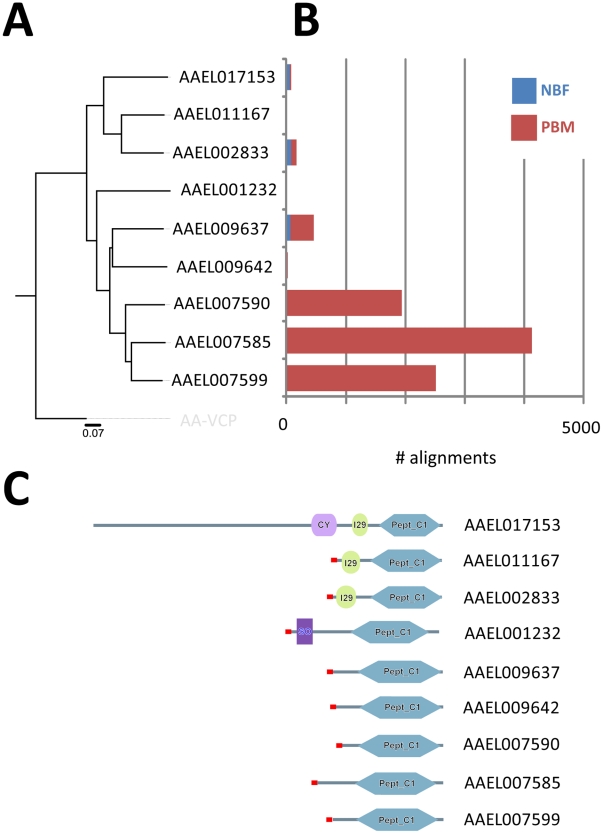
The VCB family of Aedes aegypti.
A. Neighbor joining tree showing evolutionary relationships of Ae. aegypti VCBs. B. Number of VCB reads identified in the NBF and PBM libraries. All cathepsins identified in Ae. aegypti which had reads align using the methods used for sequence alignment and data analysis, are represented. C. Domain structure of Ae. aegypti VCB proteins. Cy - Cystatin-like domain, Pept_C1 - Papain family cysteine protease domain, I29 - Cathepsin propeptide inhibitor domain, SO - Somatomedin B -like domain. Signal peptides are labeled red.